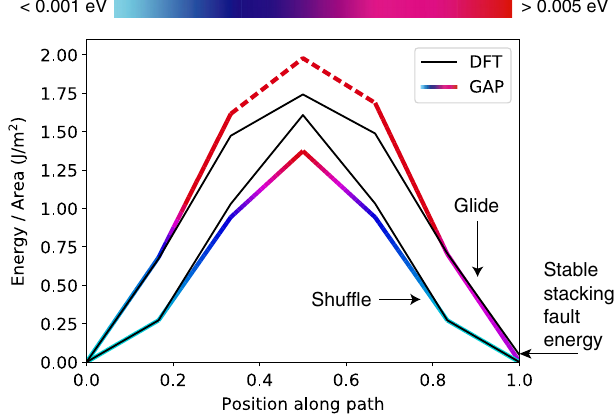
FIG. 21. Relaxed generalized stacking-fault energies along minimum barrier energy path directions ( ½ 112 (cid:3) for glide and ½ 110 (cid:3) for shuffle) computed with the DFT (black solid lines) and the GAP. The thick curve showing the GAP model energies is colored according to the maximum per-atom predicted error of the GAP model and dashed where the predicted error exceeds the scale maximum of 5 meV per atom. The upper two curves correspond to the glide plane and the lower two to the shuffle plane.